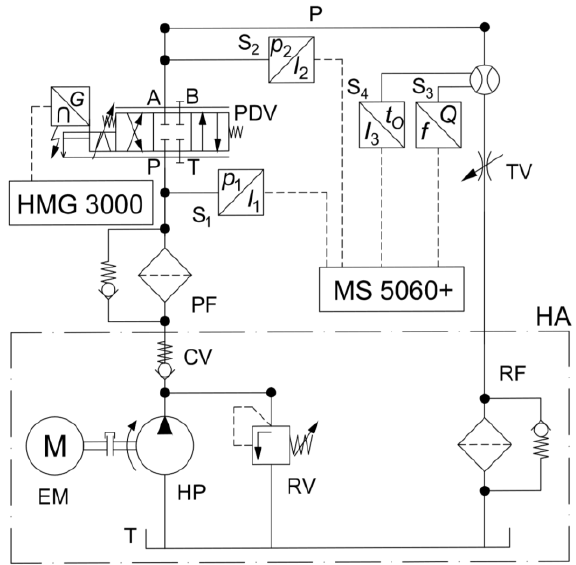
Fig. 2. Scheme of hydraulic circuit of experimental equipment Table 1. List of used parts